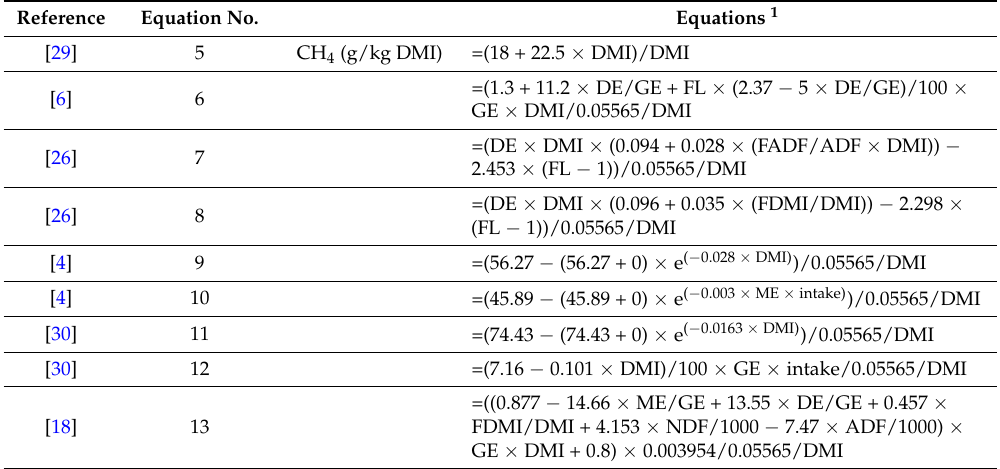
Table 3. Selected enteric CH 4 prediction equations from the literature evaluated in present study with emissions expressed per kilogram of DM intake.